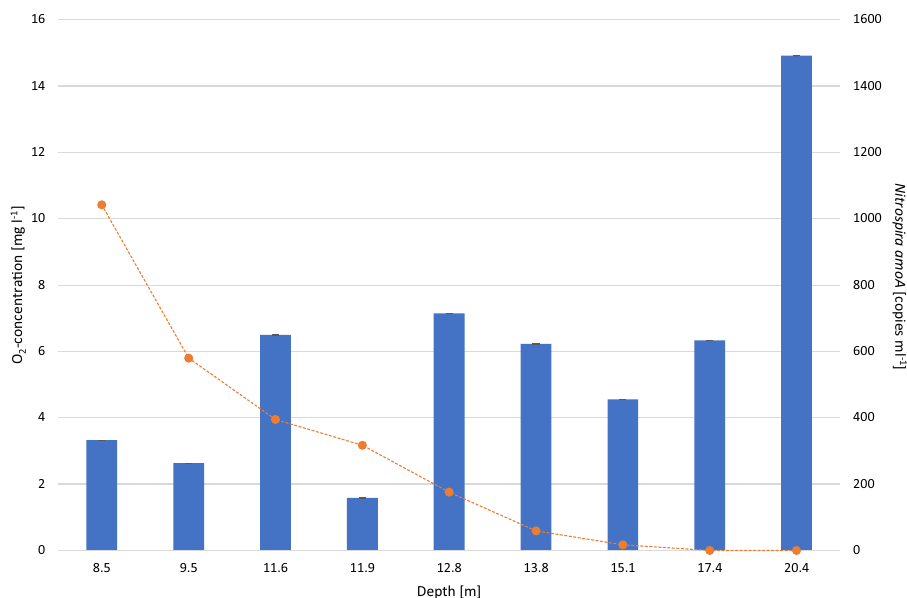
Figure 4. Concentration of dissolved oxygen (orange line) and Nitrospira amoA gene copy numbers (blue bars) in samples of the sediment/water-interface at different depths. Error bars indicate 95% Poisson confidence